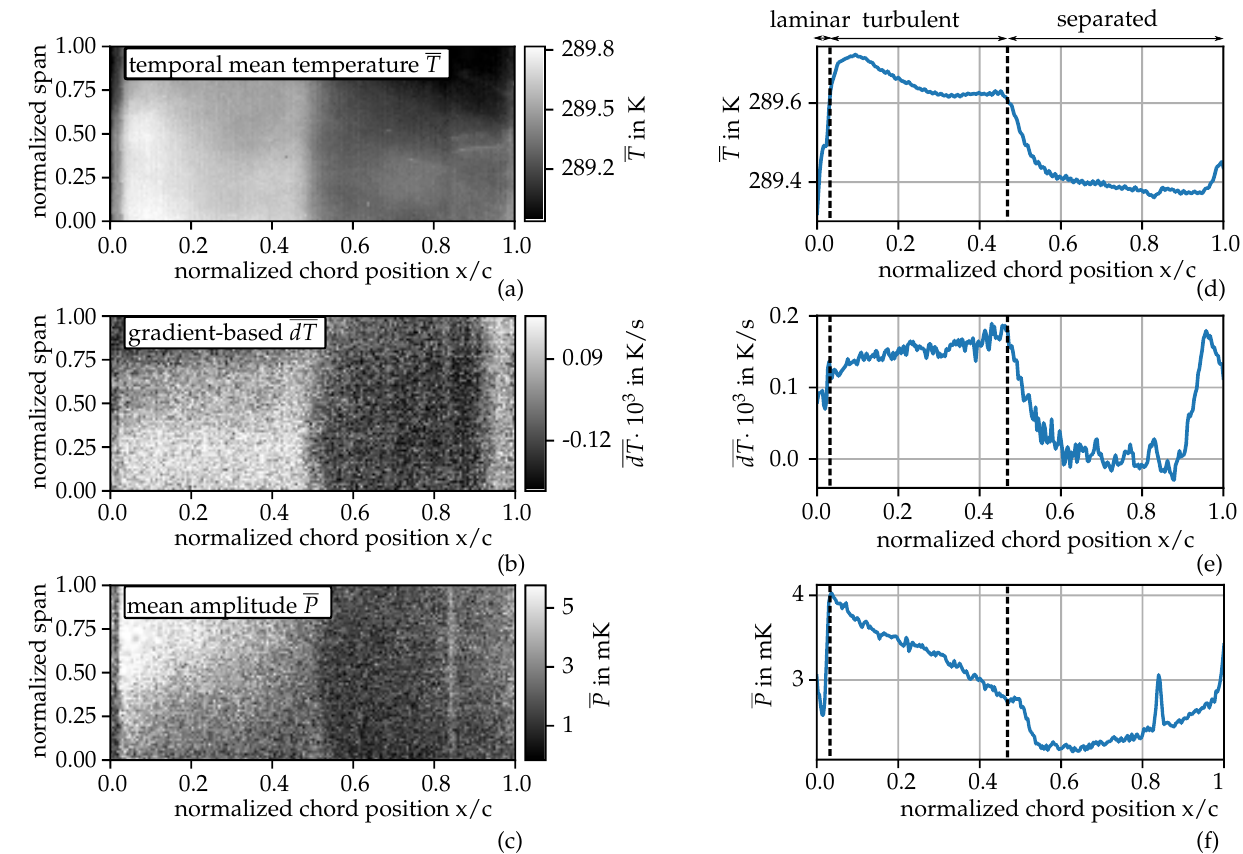
Figure 8. Comparison of the evaluation of thermographic image series by the mean temperature ( a , d ), gradient-based ( b , e ) and the harmonic signal processing approach ( c , f ) for a measuring object with near thermodynamic steady state behaviour. Left side ( a – c ): processed thermographic images, right side ( d – f ): averaged profiles over the chord position. Experimental parameters: Re = 2 · 10 6 , AoA = 14 ◦